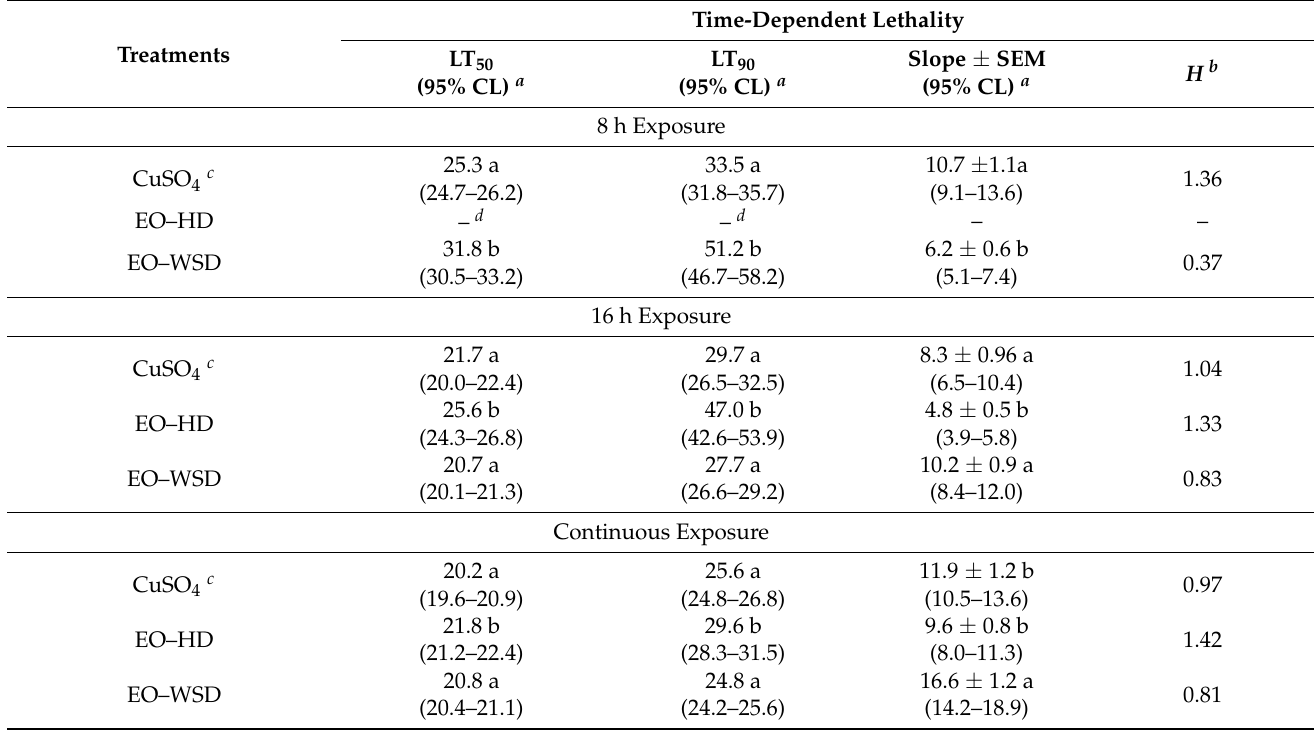
Table 3. Estimated lethal time of 50 and 90 (LT 50 and LT 90 ) of the essential oils (EOs) of Azorean Cryptomeria japonica leaf obtained by two distillation techniques against adults of Radix peregra , assessed for different exposure periods at 100 µ g/mL.